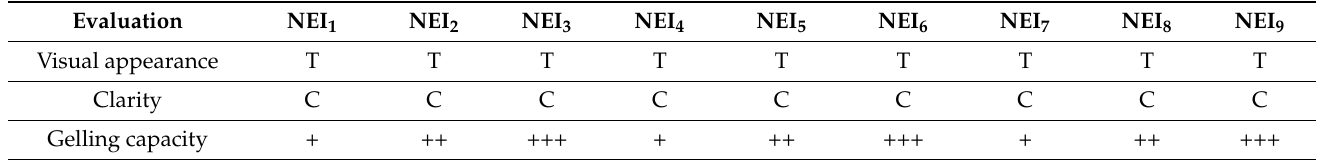
Table 2. Visual appearance, Clarity, and Gelling Capacity.